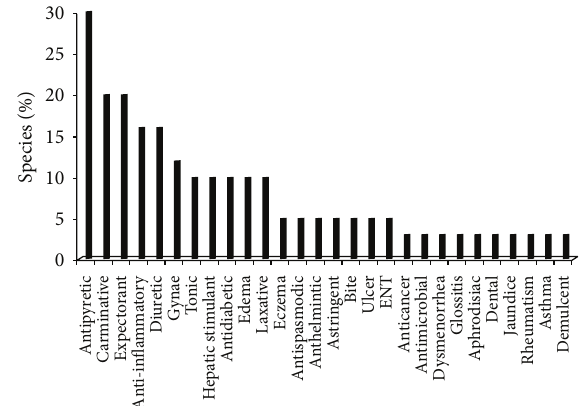
Figure 3: Percentage of medicinal plant species used for curing various